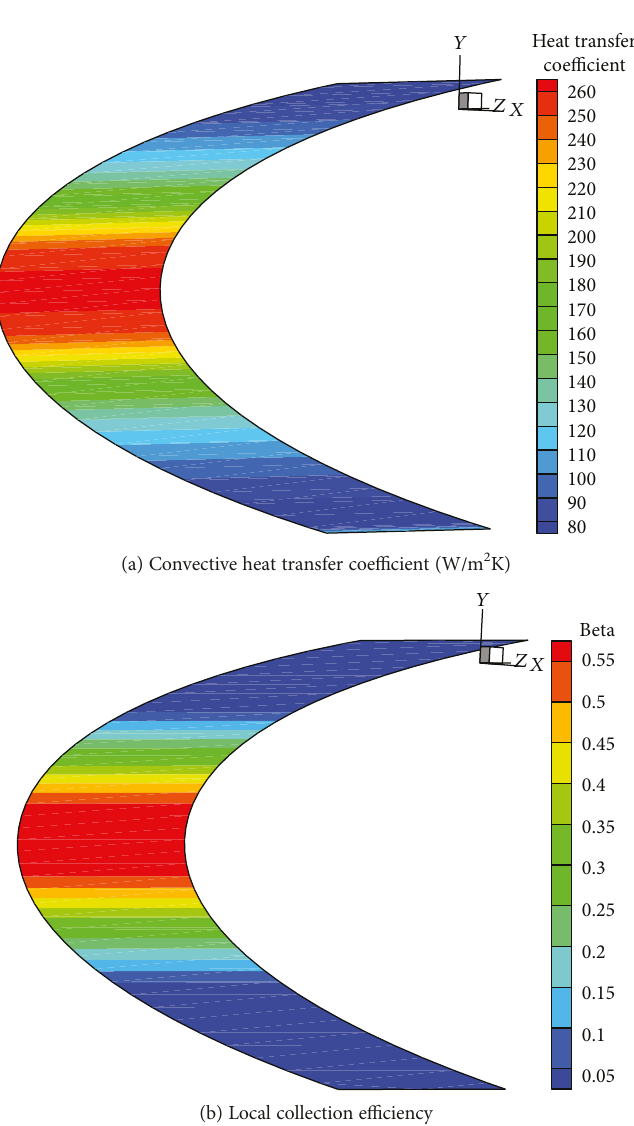
Figure 11: Contour of convective heat transfer and droplet